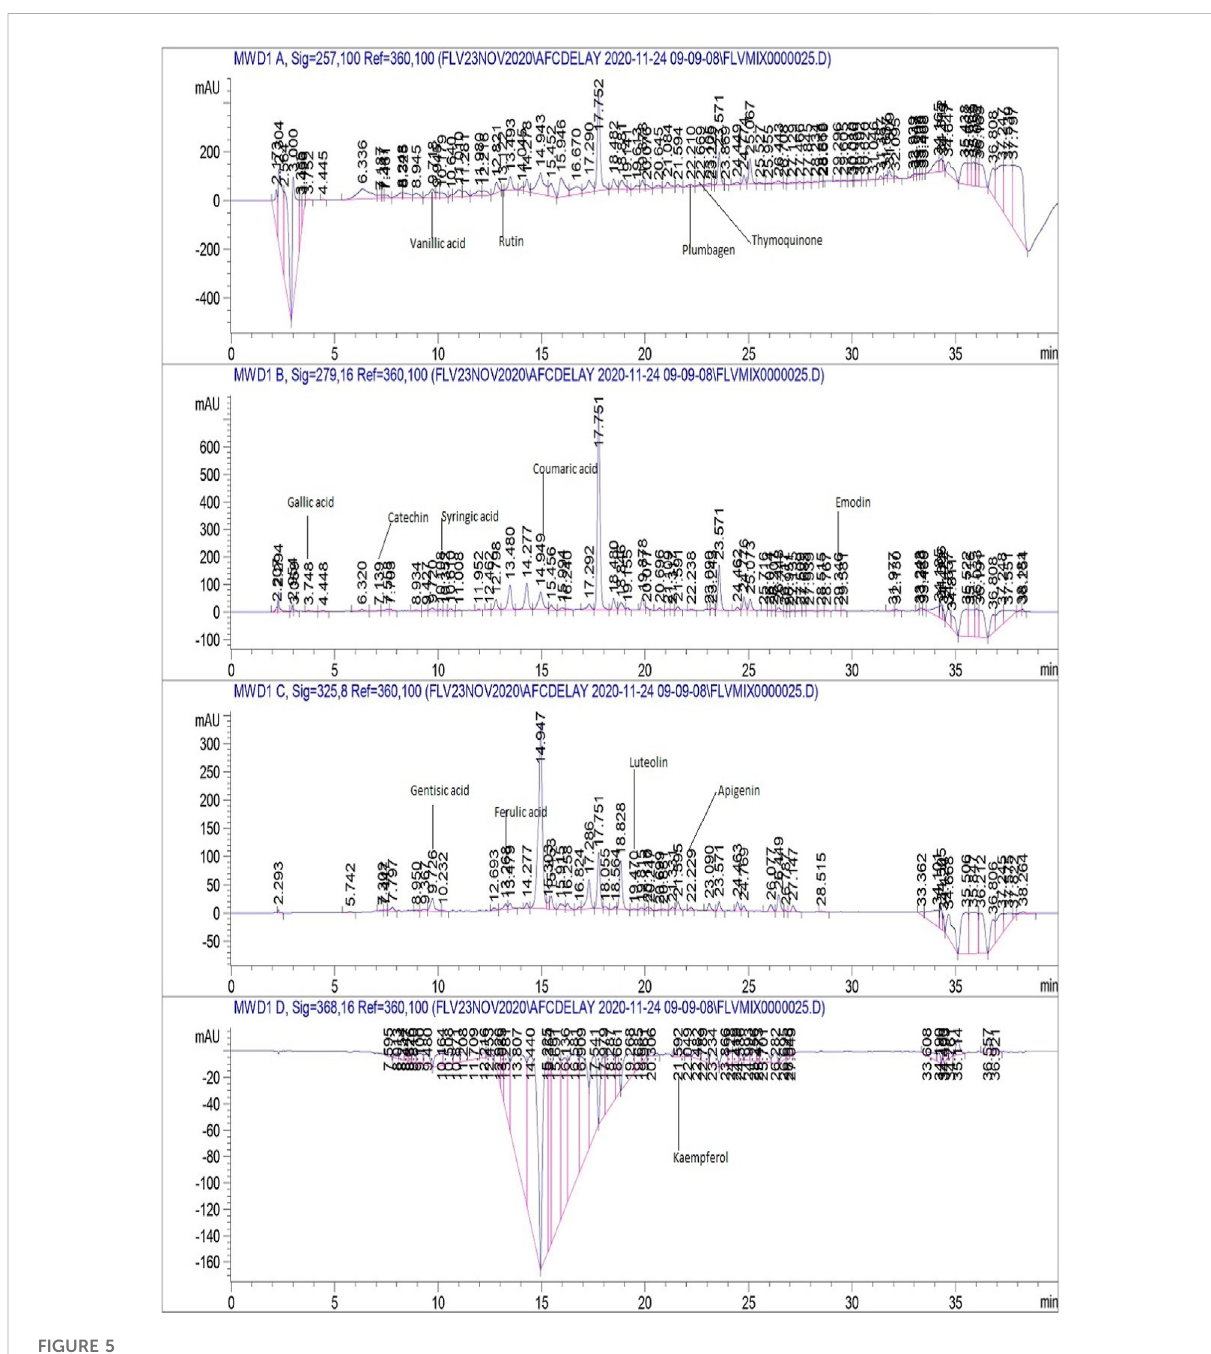
FIGURE 5 HPLC chromatogram of M. piperita M